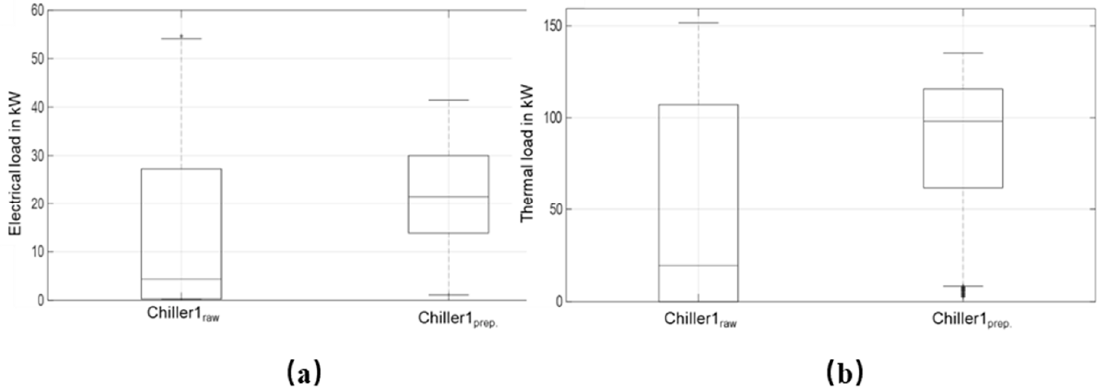
Figure 2. ( a ) Data overview before and after data pre-processing for the electrical load of chiller 1; ( b ) data overview before and after data pre-processing for the thermal load of chiller 1.